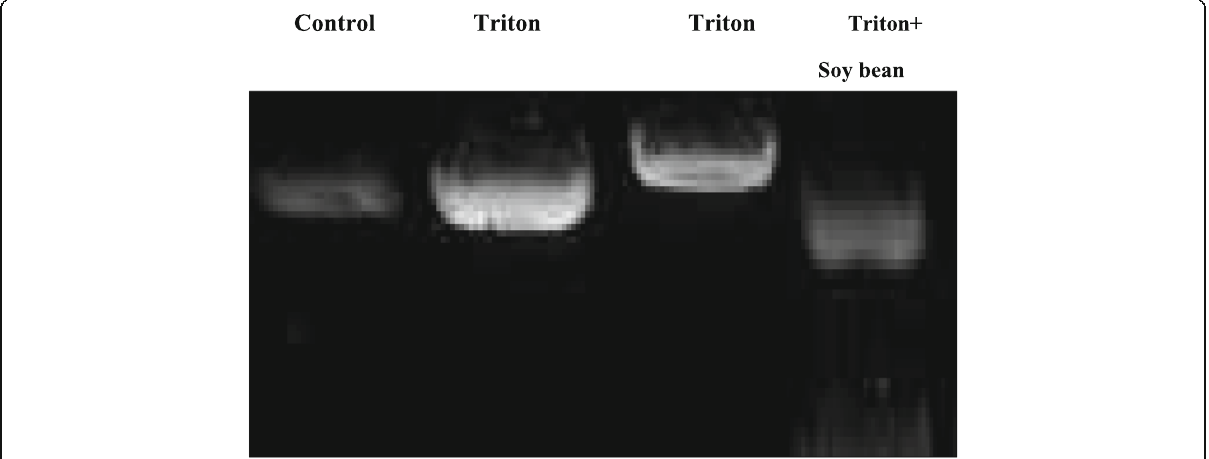
Fig. 4 Brain DNA fragmentation on agarose gel electrophoresis of the different experimental groups. The first lane: control; the second and third lanes: triton-treated rats and the fourth lane: triton + soybean-treated